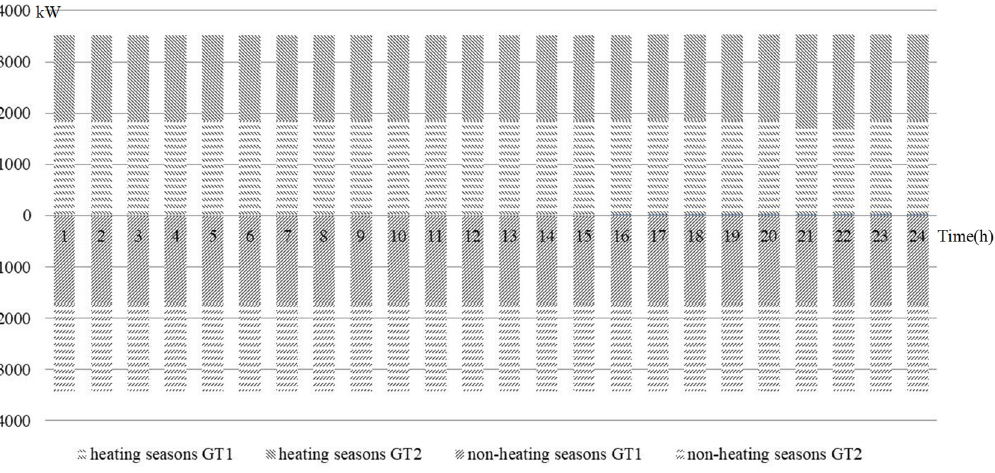
Figure 3. The output of GTs in different periods.